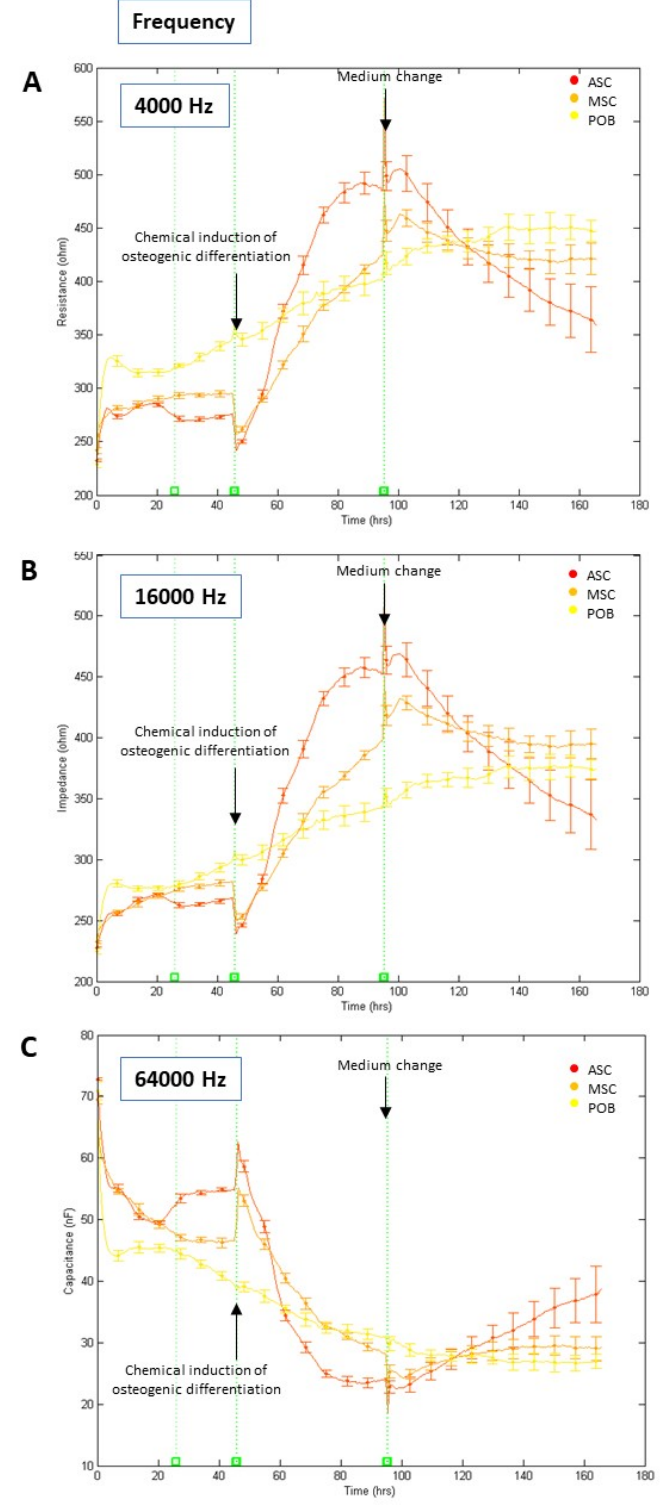
Figure 2. ( A–C ) Determination of impedance parameters after chemical osteogenic induction. Normalized real-time and label-free impedance (frequencies at 4 (2A), 16 (2B), 64 (2C) kHz) curves of human adipose-derived stem cells (ASC, red line), bone-marrow-derived stem cells (BMSC, orange line), and primary osteoblasts (POB, yellow line), (mean ± SD, n = 3). All cells were seeded (t = 0 h) in multi-well electrode arrays. Chemical osteogenic induction was started (t = 48 h) by supplementation with an osteogenic differentiation medium. At t = 96 h, the last medium change